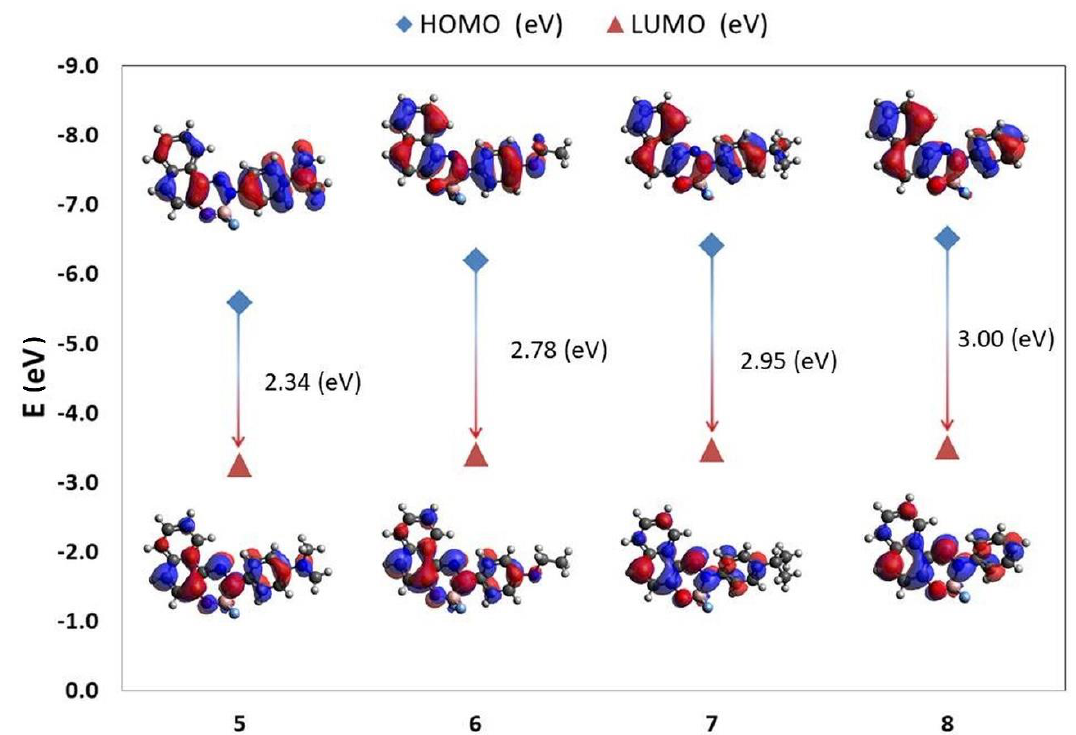
Figure 10. Graphic representation of HOMO and LUMO orbitals for difluoroboranes of 1-phenylazonaphthalen-2-ols ( 5–8 ) calculated in DMSO.